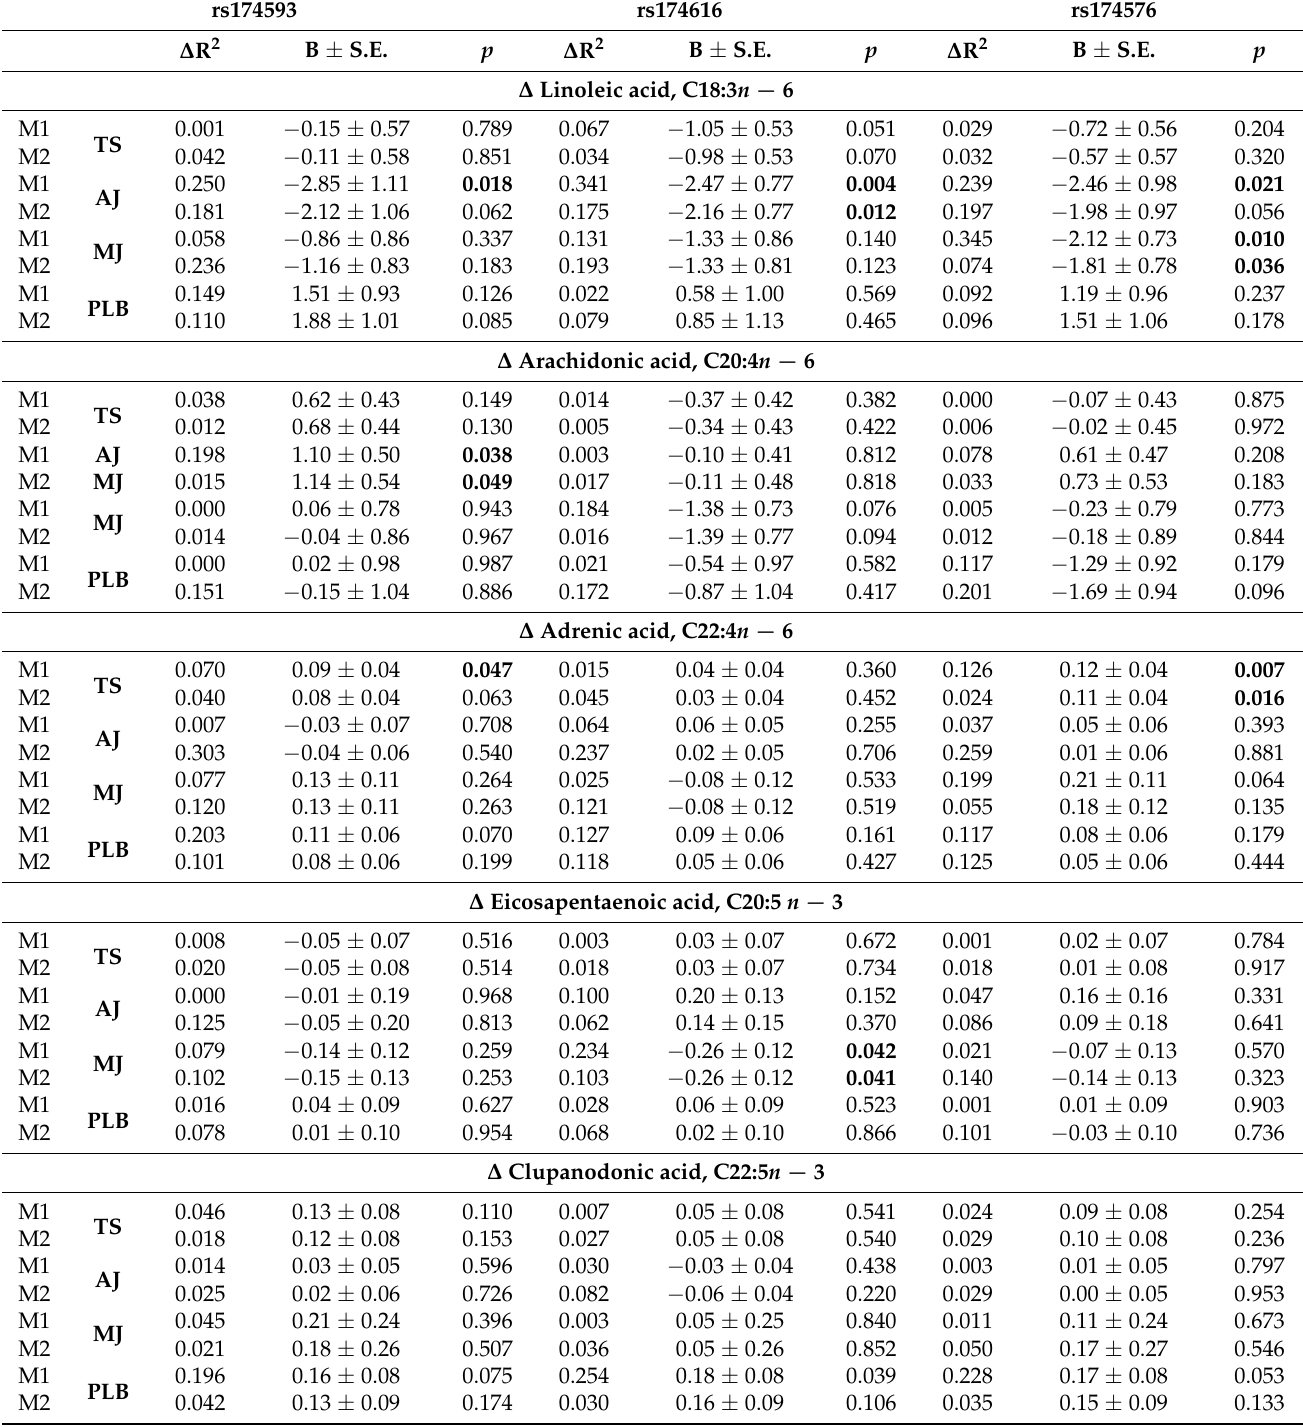
Table 1. Associations between FADS2 variants (rs174593, rs174616, rs174576) and changes in long-chain polyunsaturated fatty acids in plasma phospholipids in subjects who are overweight (BMI ≥ 25), across the study intervention groups with varying polyphenol